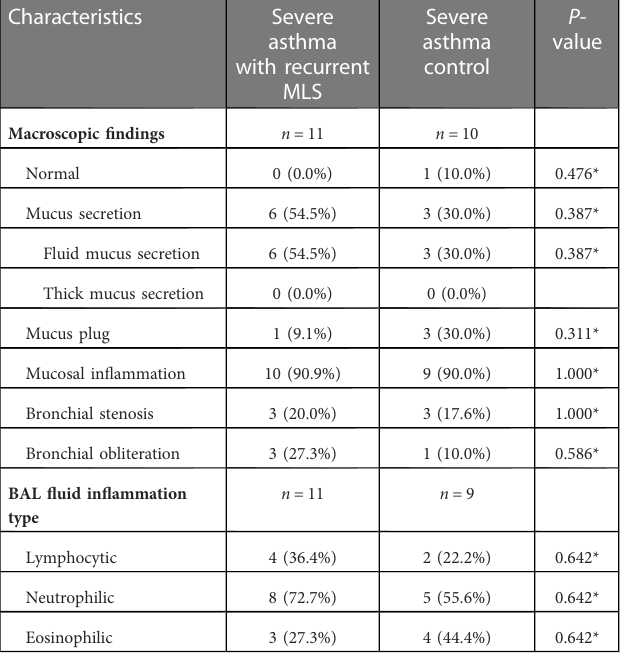
TABLE 4 Bronchoscopy fi ndings of children with severe asthma strati fi ed by recurrent MLS. Characteristics